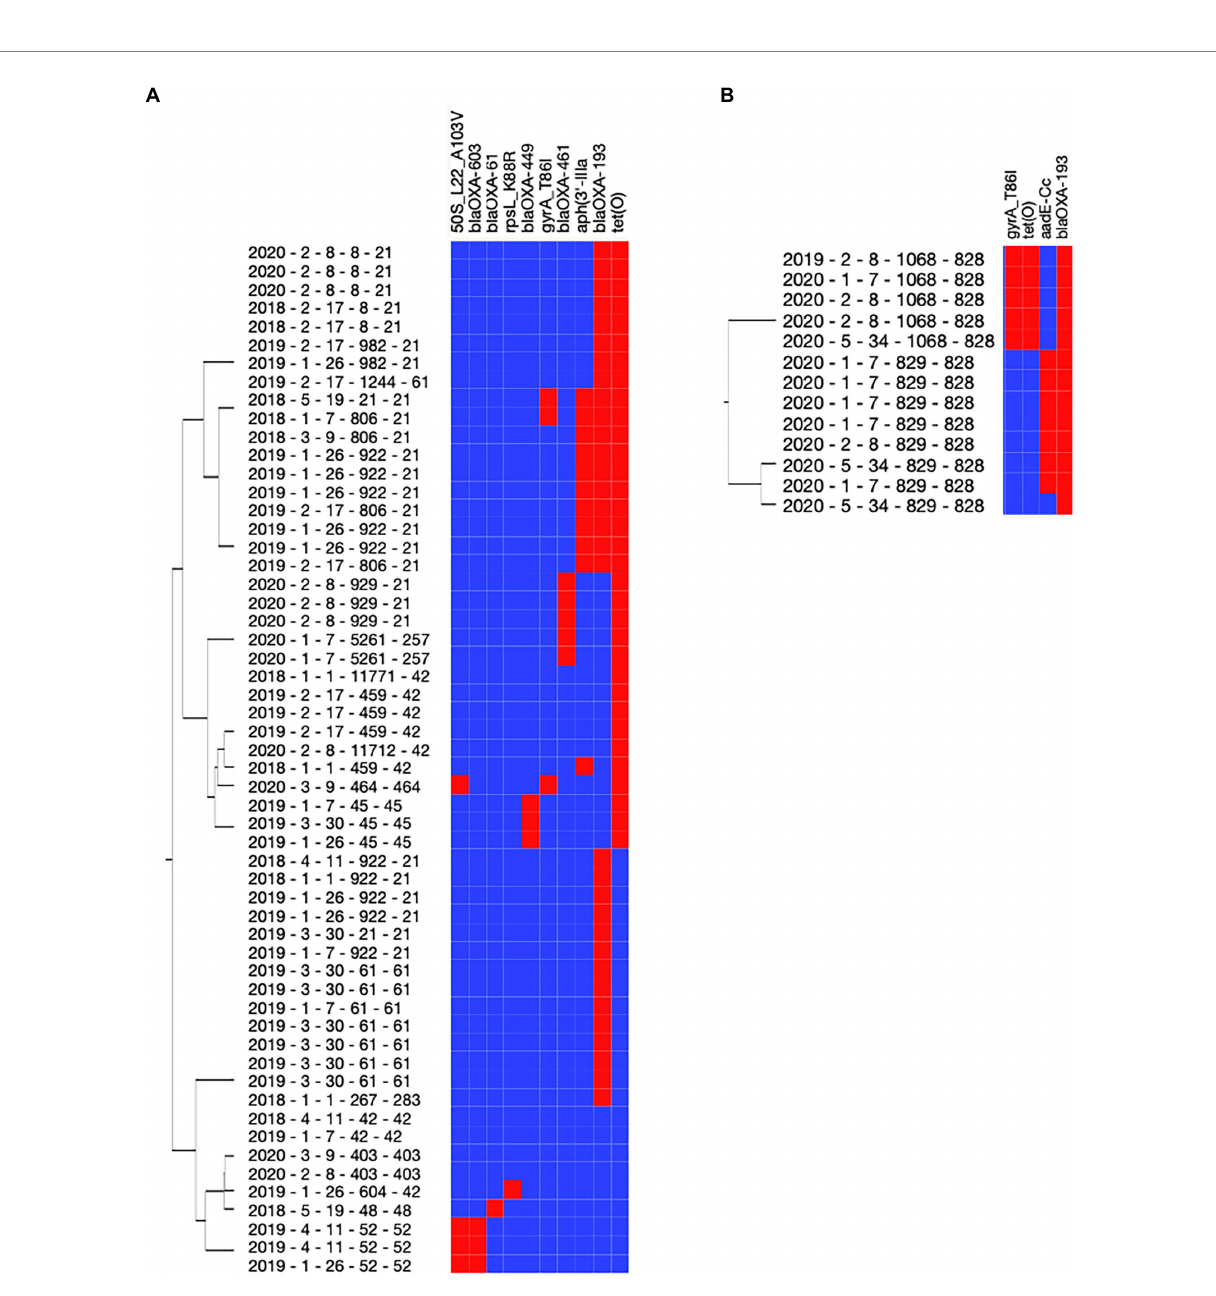
FIGURE 4 Antimicrobial resistance gene content of Campylobacter spp. isolated from dairy manure in small specialty crops farms in Northeast Ohio from 2018 to 2020. Resistome of Campylobacter jejuni (A) and Campylobacter coli (B) . Eleven genes were detected across the 69 Campylobacter isolates using the NARMS database. The tree associated with the Y-axis displays the similarities of resistome profile among the isolates. Red and blue cells represent genes detected or missing (Y-axis) in the designated Campylobacter isolate (X-axis), respectively. Metadata associated with the Campylobacter spp. isolates are presented in the following order: year of collection (2018–2020), farm cluster (1–5), farm ID (#1–#34), sequence type (ST), and clonal complex